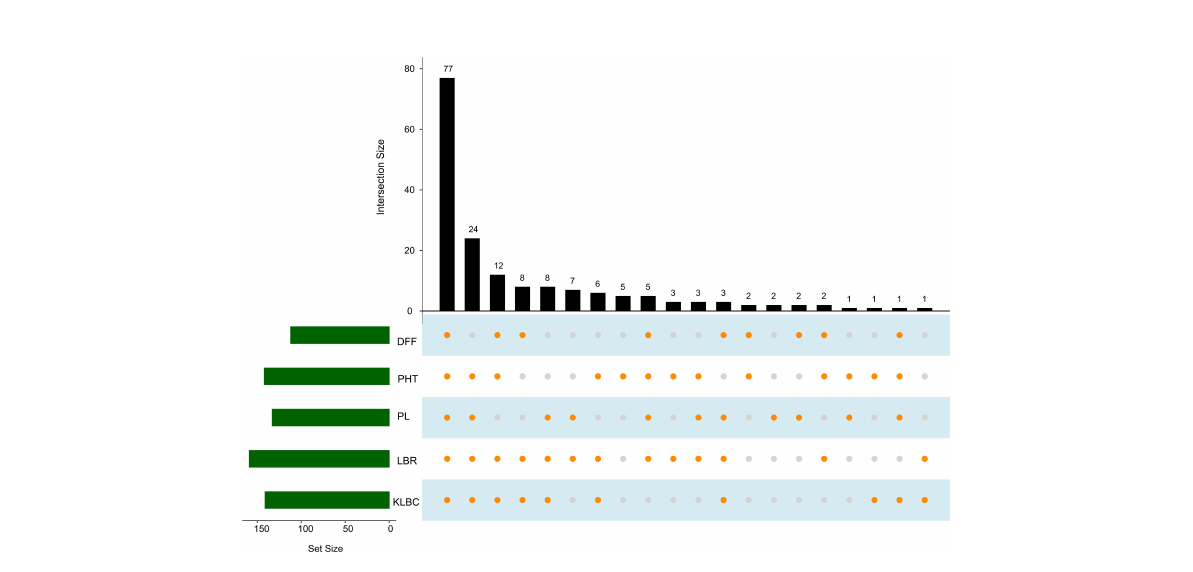
FIGURE 7 Upset plot indicating genotype groups for elite allelic combinations for each trait. Green set size bar indicating the number of selected genotypes for each trait. Orange dots connected by lines corresponding to the bar graph indicate the number of selected genotypes which overlaps among traits. (DFF, Days to fi fty percent fl owering; PHT, Plant height in cm; PL, Panicle length in